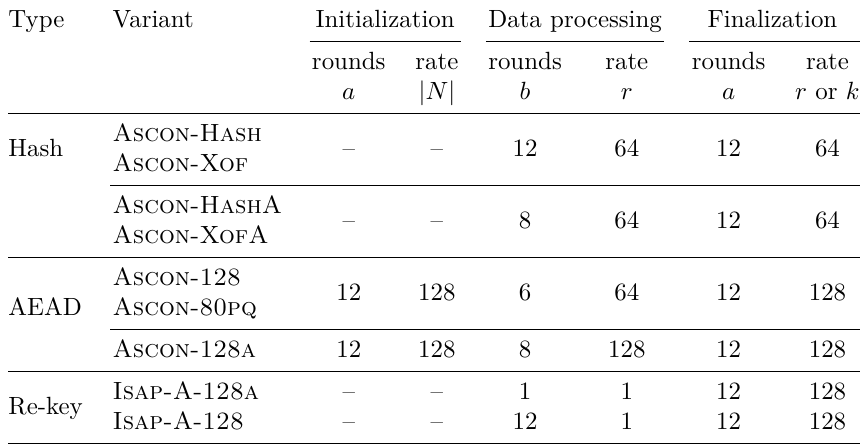
Table 2: Number of rounds and rate used in the Ascon and Isap family members [DEMS21a, DEM + 21]. In the initialization and finalization phases, the rate refers to the absorbing rate of the nonce N and the squeezing rate of the tag T or hash H , respectively.